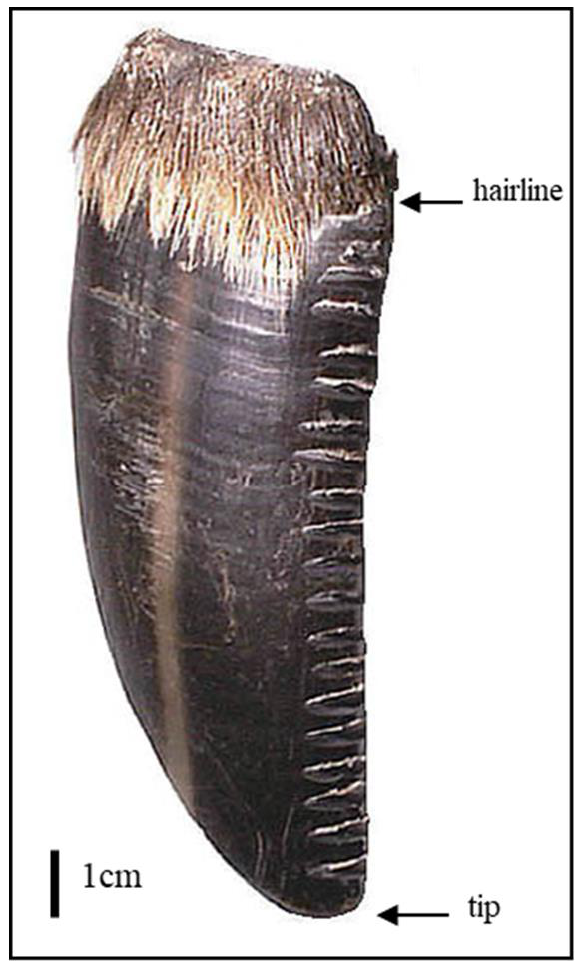
Figure 2. Moose hoof digit sampled for stable isotope analysis in 0.5-cm increments between the hairline and